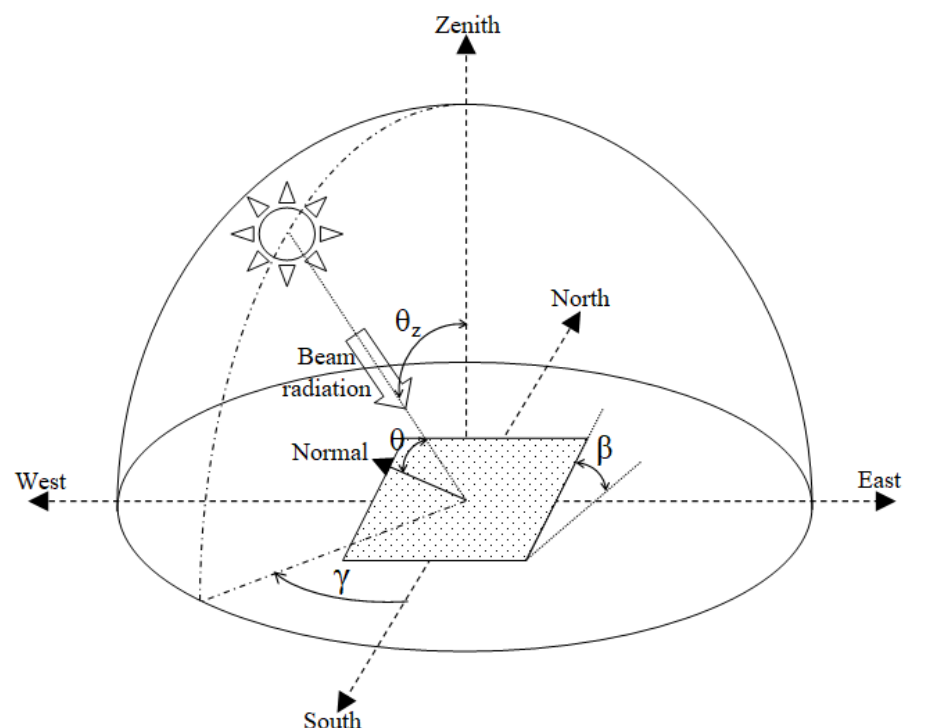
Figure 1. Basic solar angles associated with the tilted panel.